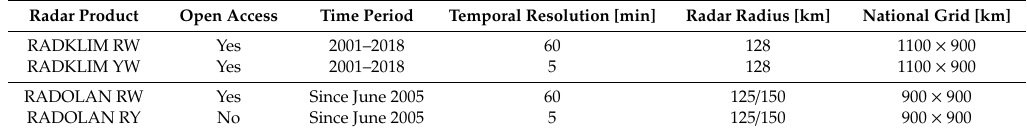
Table 1. Overview of the final RADKLIM and RADOLAN composite